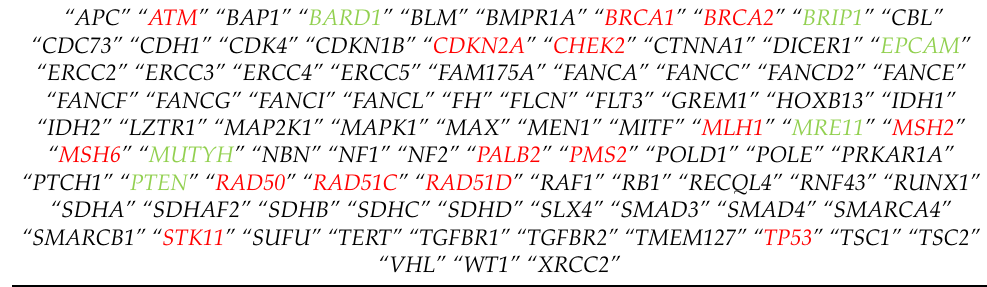
Figure 1. Algorithm to facilitate clinical practice decisions on management of DNA damage repair-deficient pancreatic ductal adenocarcinoma, following the recommendations from the European Society of Digestive Oncology expert panel. HRR, homologous recombination repair; PDAC, pancreatic ductal adenocarcinoma; * full panel, see Table 2. Table 2. Proposed somatic and germline DDR gene panel—Compilation of participating centres.